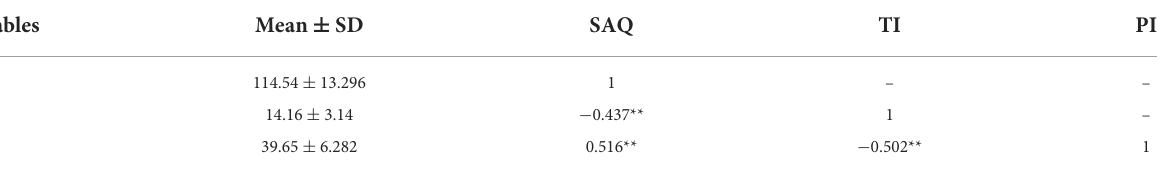
TABLE 2 The correlation analysis among research